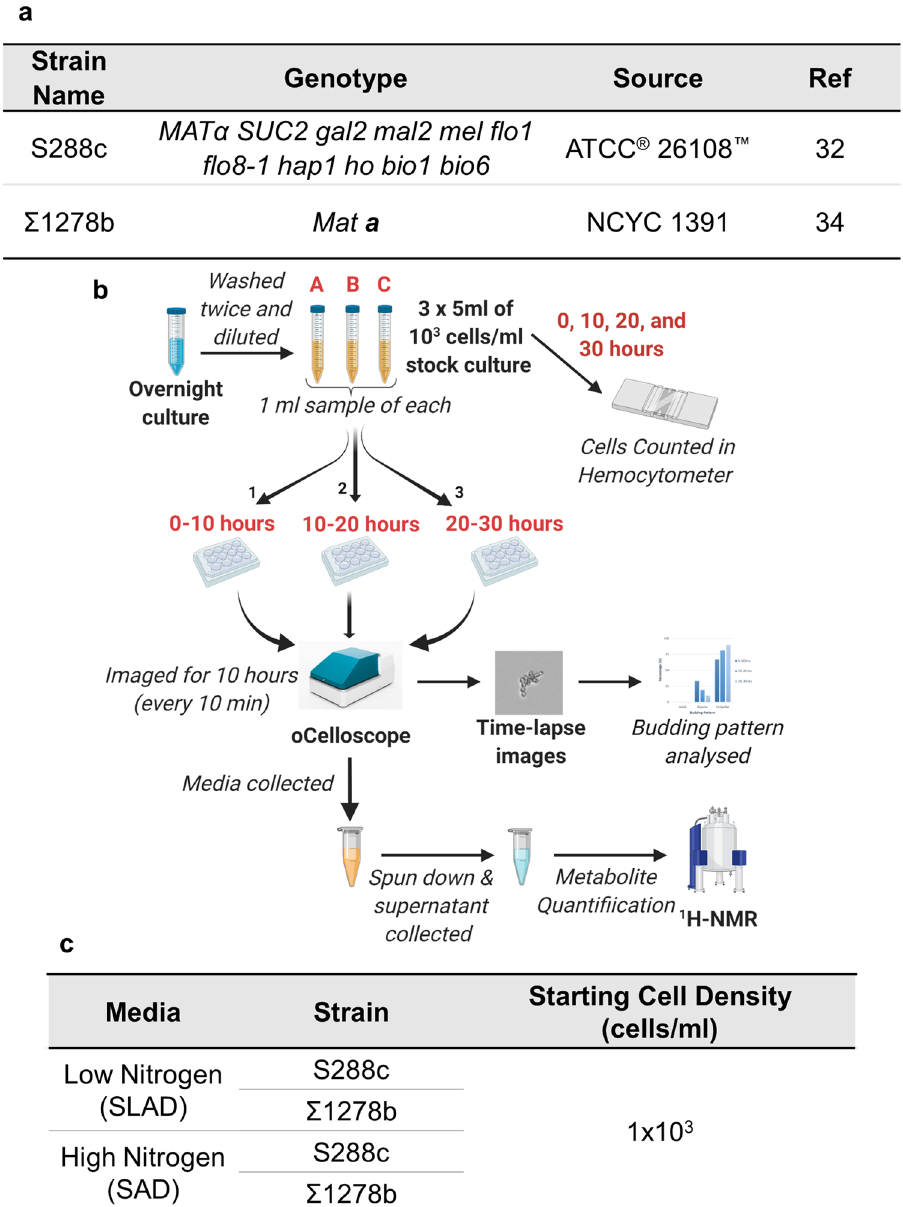
Figure 6. The budding patterns of S. cerevisiae cells growing in low and high nitrogen liquid media were tracked during growth and correlated to cell density and metabolite concentration. ( a ) S. cerevisiae strains used in this study. ( b ) Schematic of the time series experiment that utilised the oCelloScope™ for image acquisition and 1 H NMR for metabolite identification and quantification. ( c ) Experimental conditions used in the time series